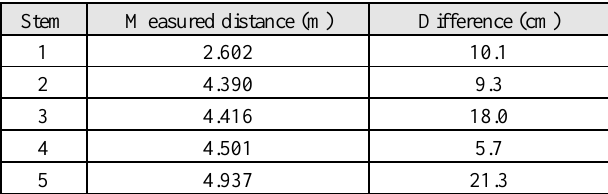
Table 3. Error assessment with